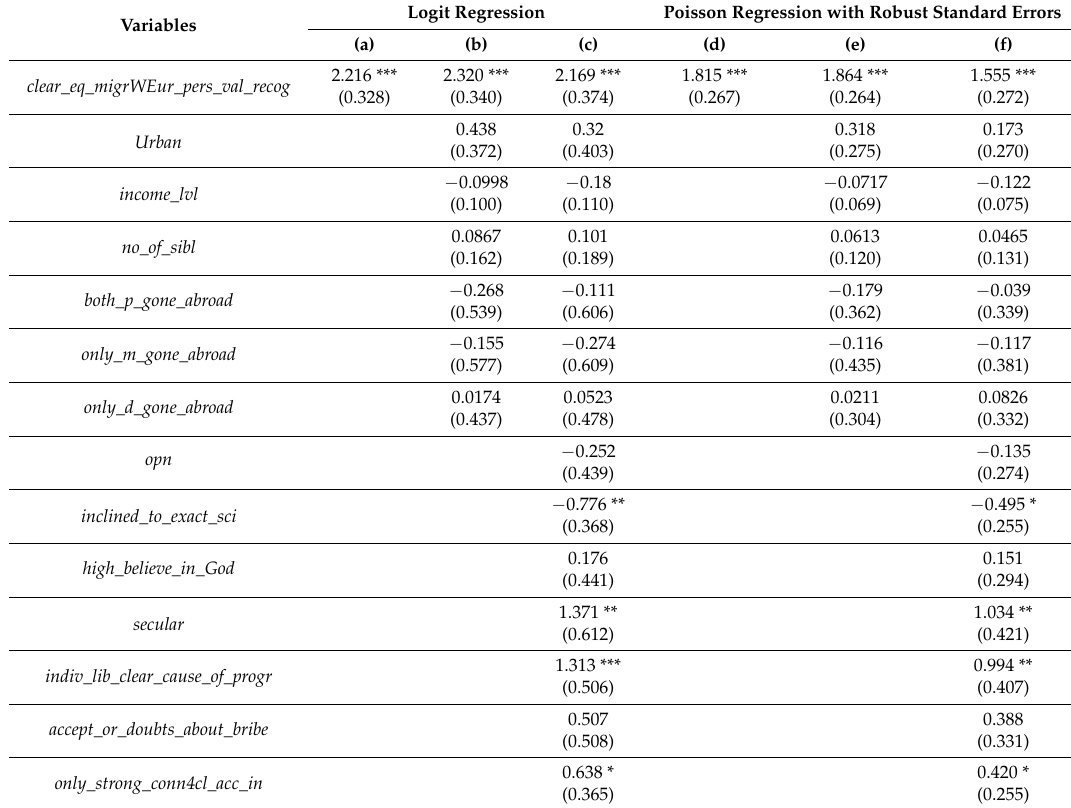
Table 4. Raw coefficients (Logit vs. Poisson) of the model based on responses from FSE, ULBS